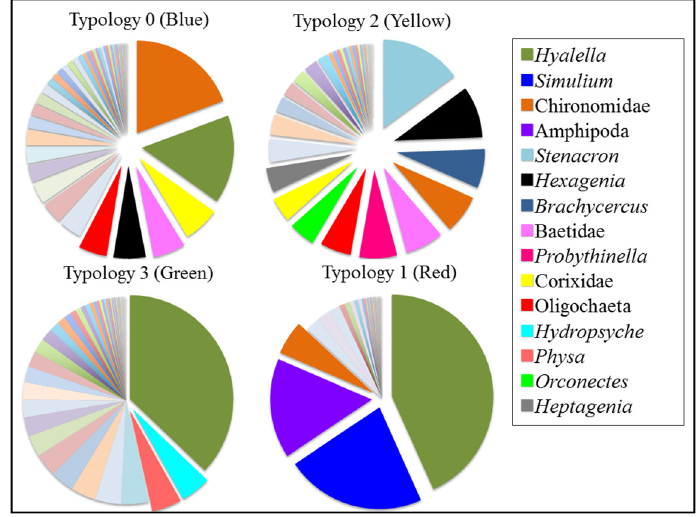
Figure 9. Population breakdown in each typology, with the most abundant genera ( ≥ 5% of the population) named in the legend.